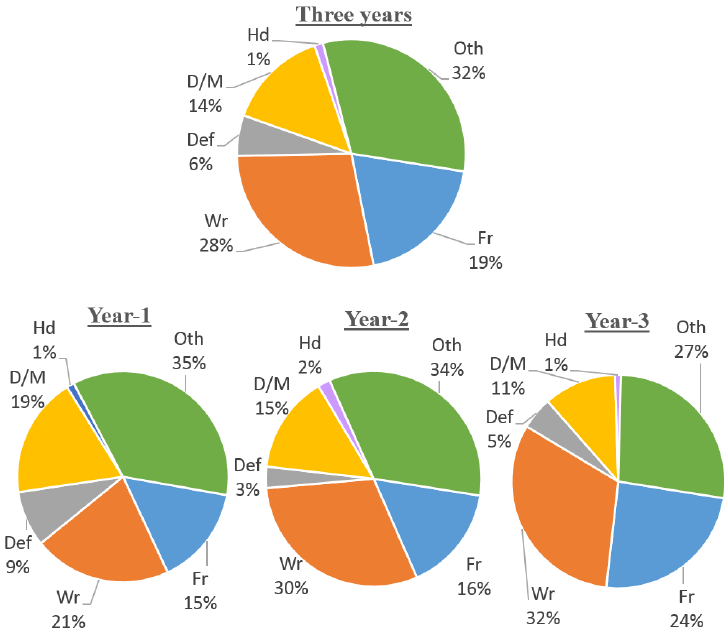
Figure 9. Overall breakdown of correctable die defects during three years (total and annual).